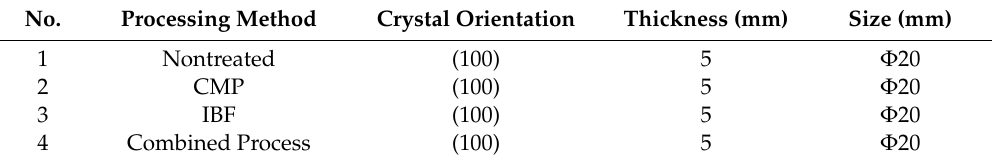
Table 4. Sample number and treatment process. CMP—Chemical Mechanical Polishing; IBF—Ion Beam Figuring.